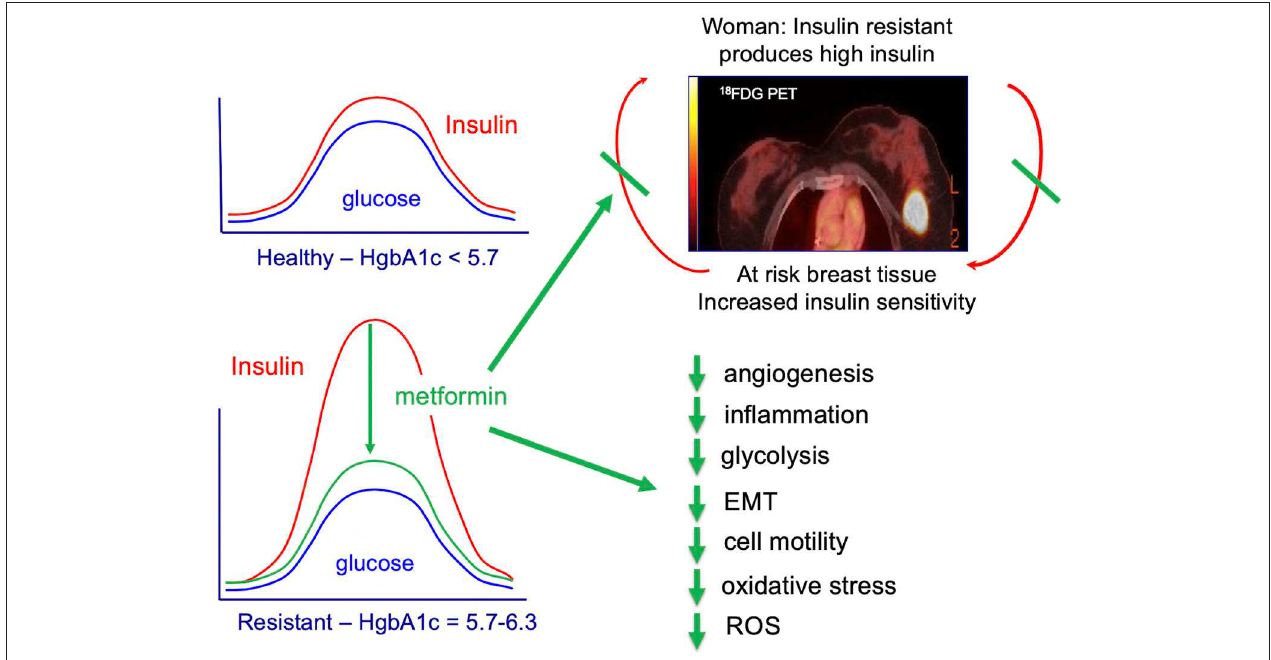
FIGURE 7 | Impact of metformin on cancer